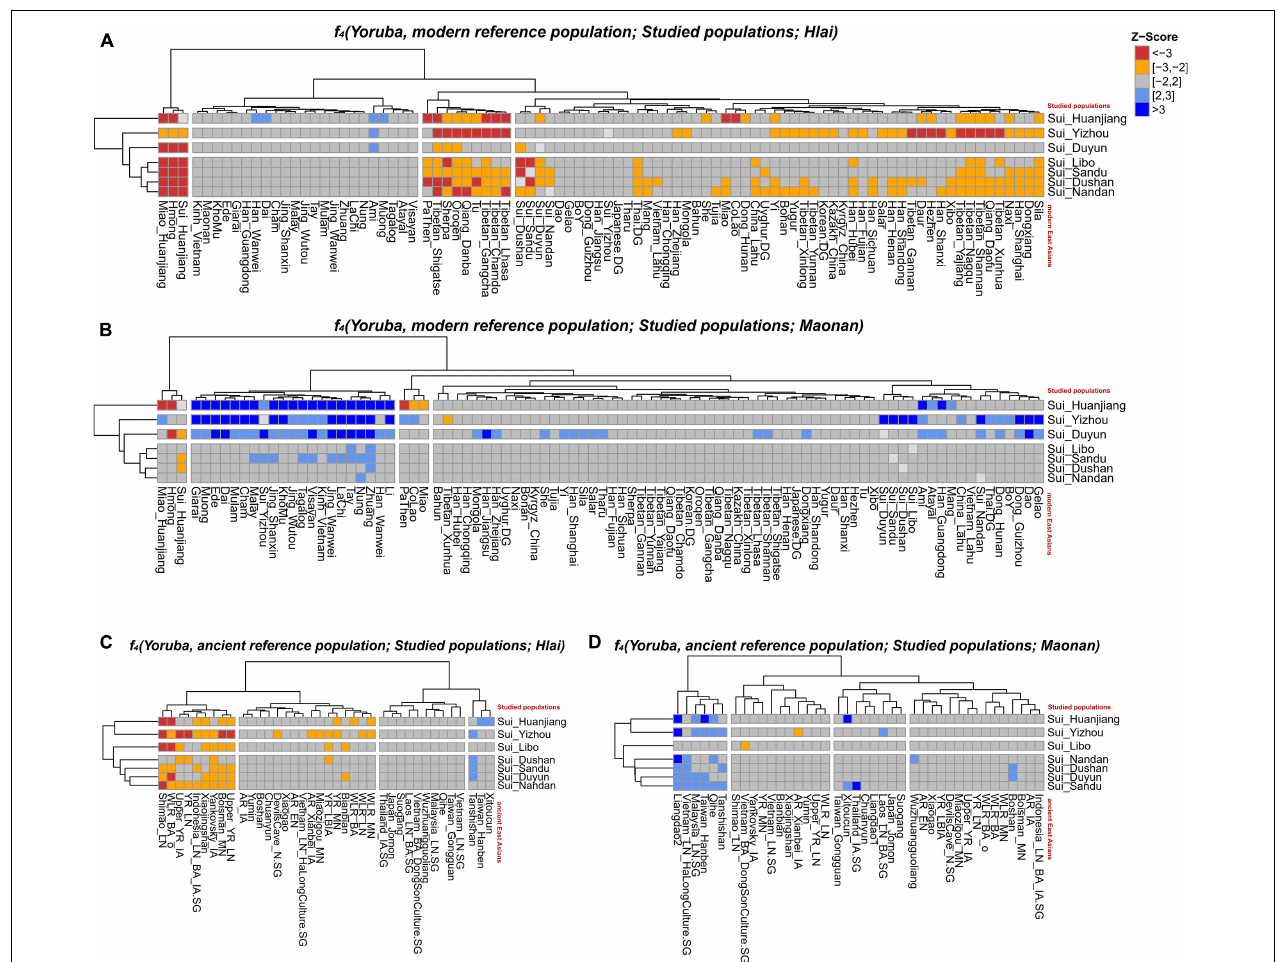
FIGURE 7 | A series of f 4 statistics performed in the form of (A) f 4 (Yoruba, modern EAs; studied groups; Hlai); (B) f 4 (Yoruba, modern EAs; studied groups, Maonan); (C) f 4 (Yoruba, ancient EAs; studied groups; Hlai); (D) f 4 (Yoruba, ancient EAs; studied groups, Maonan) to explore the genetic similarities and differentiation between studied Sui groups and Tai-Kadai speaking